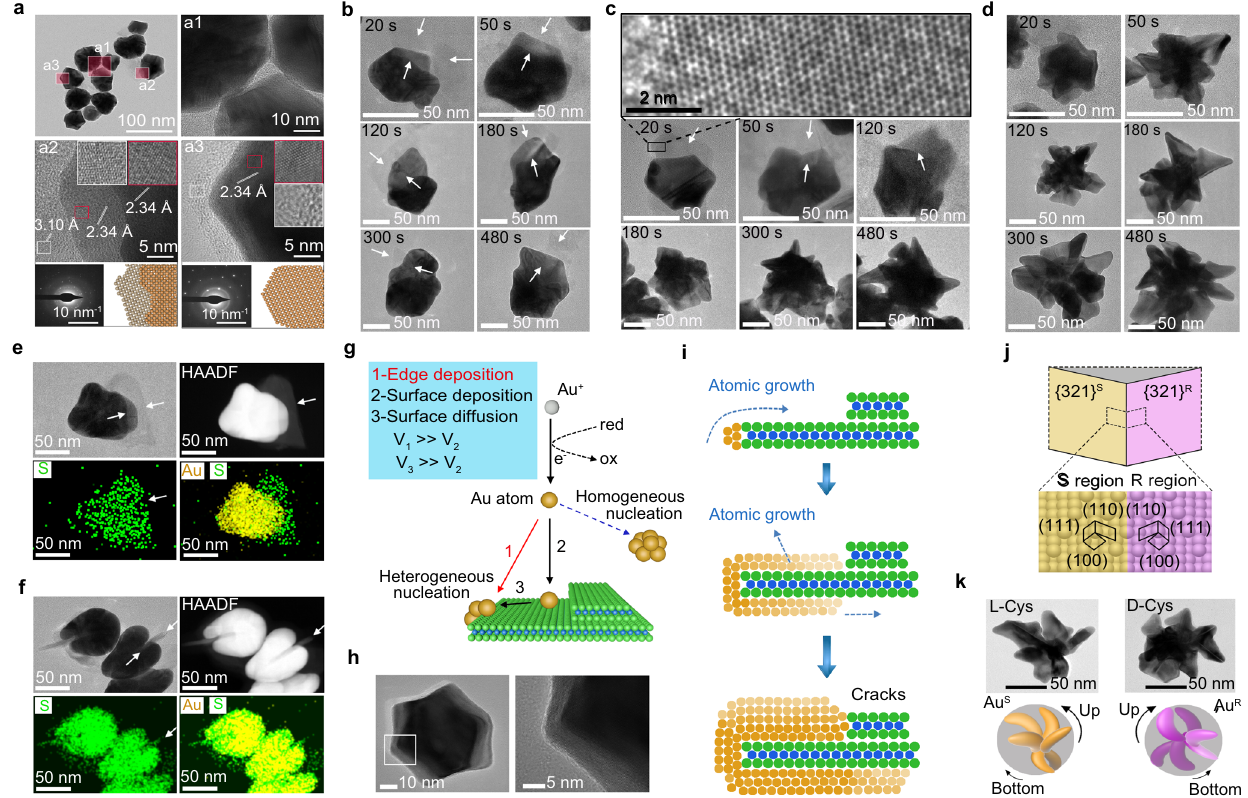
Fig. 3 | Mechanism for anisotropic growth of Au nanocrystals on hetero- stuctural MoS 2 nanosheets. a TEM, HRTEM, and the corresponding selected area electron diffraction pattern for Au/MoS 2 cracked nanocrystals (CNCs) which are synthesized in the absence of cysteine. b – d TEM and HRTEM images indicating time-resolved morphologies of Au/MoS 2 CNCs ( b ), DNCs-1 ( c ), and DNCs-2 ( d ), respectively. e , f TEM, HAADF, and EDX element map for Au/MoS 2 nanostructures obtained after reacting for 20s in the presence of 1.2 μ M L-Cys. g Illustration showing homogeneous nucleation of Au nanostructures in solution and hetero- geneous nucleation based on competitive deposition and diffusion of gold atoms